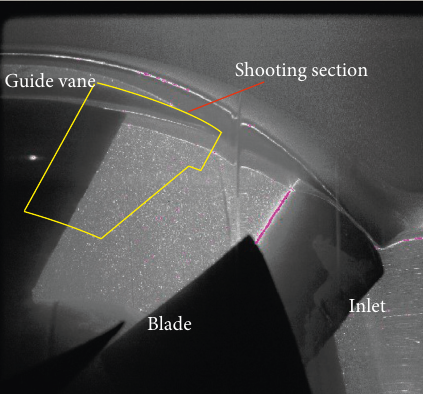
Figure 4: Tracer particle distribution in the shooting section.